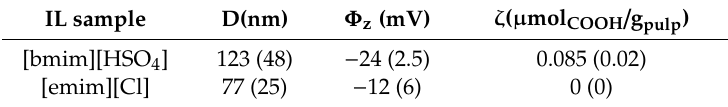
Table 4. CNC obtained from ILs treatment.